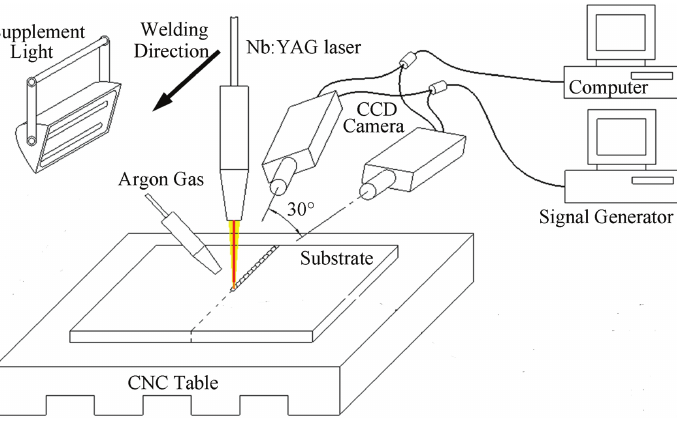
Figure 1: Schematic of experimental apparatus.